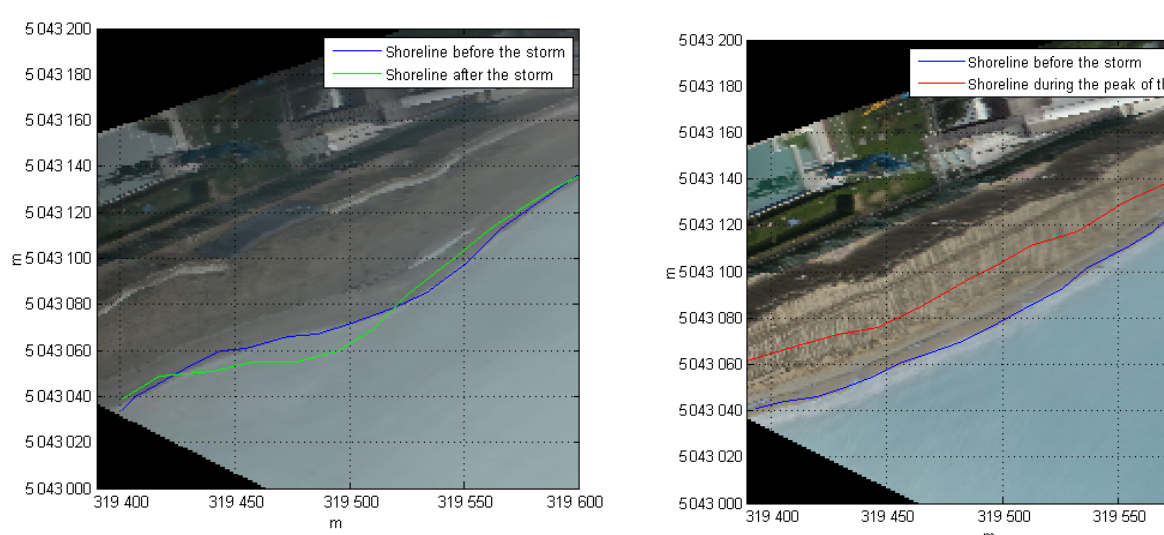
Figure 8. Detected shorelines, before and after the 7th storm.